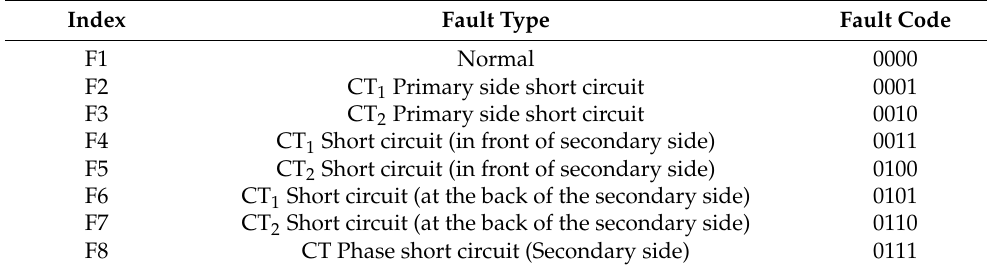
Table 6. The types and corresponding code format of the electronic current transformer